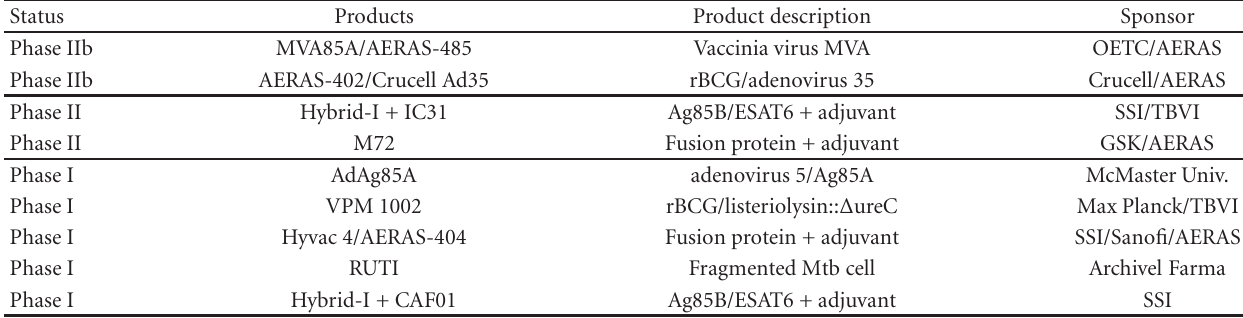
Table 1: Summary of candidate TB vaccines in clinical trials 2009. Nine candidate preventive TB vaccines are currently in clinical